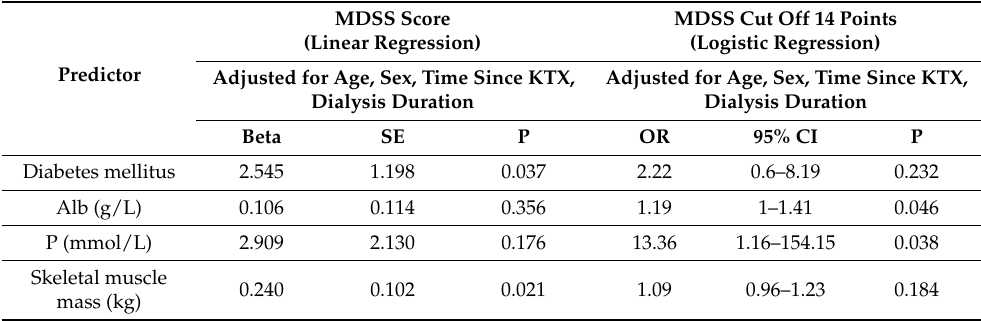
Table 2. Association between adherence to the MeDi and measured parameters (only statistically significant values shown).